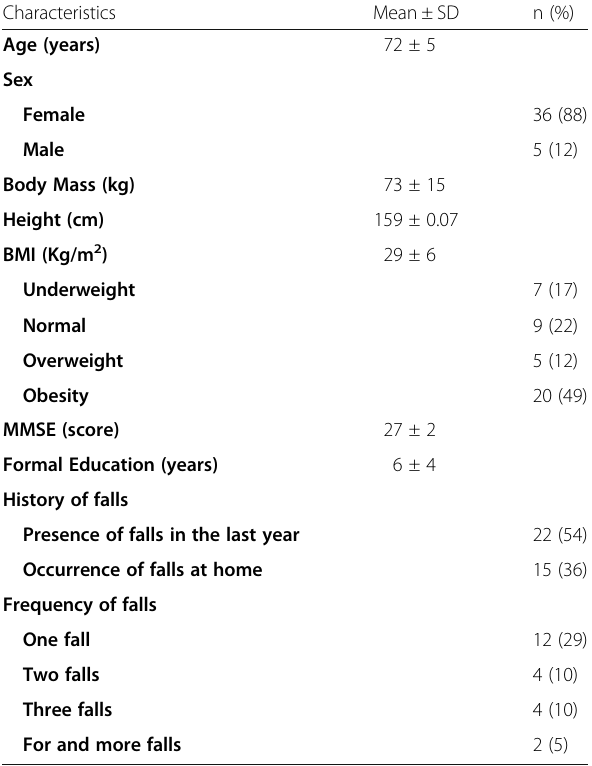
Table 1 Demographic and anthropometric characteristics and history of falls of participants ( n = 41), Curitiba, PR, Brazil, 2017